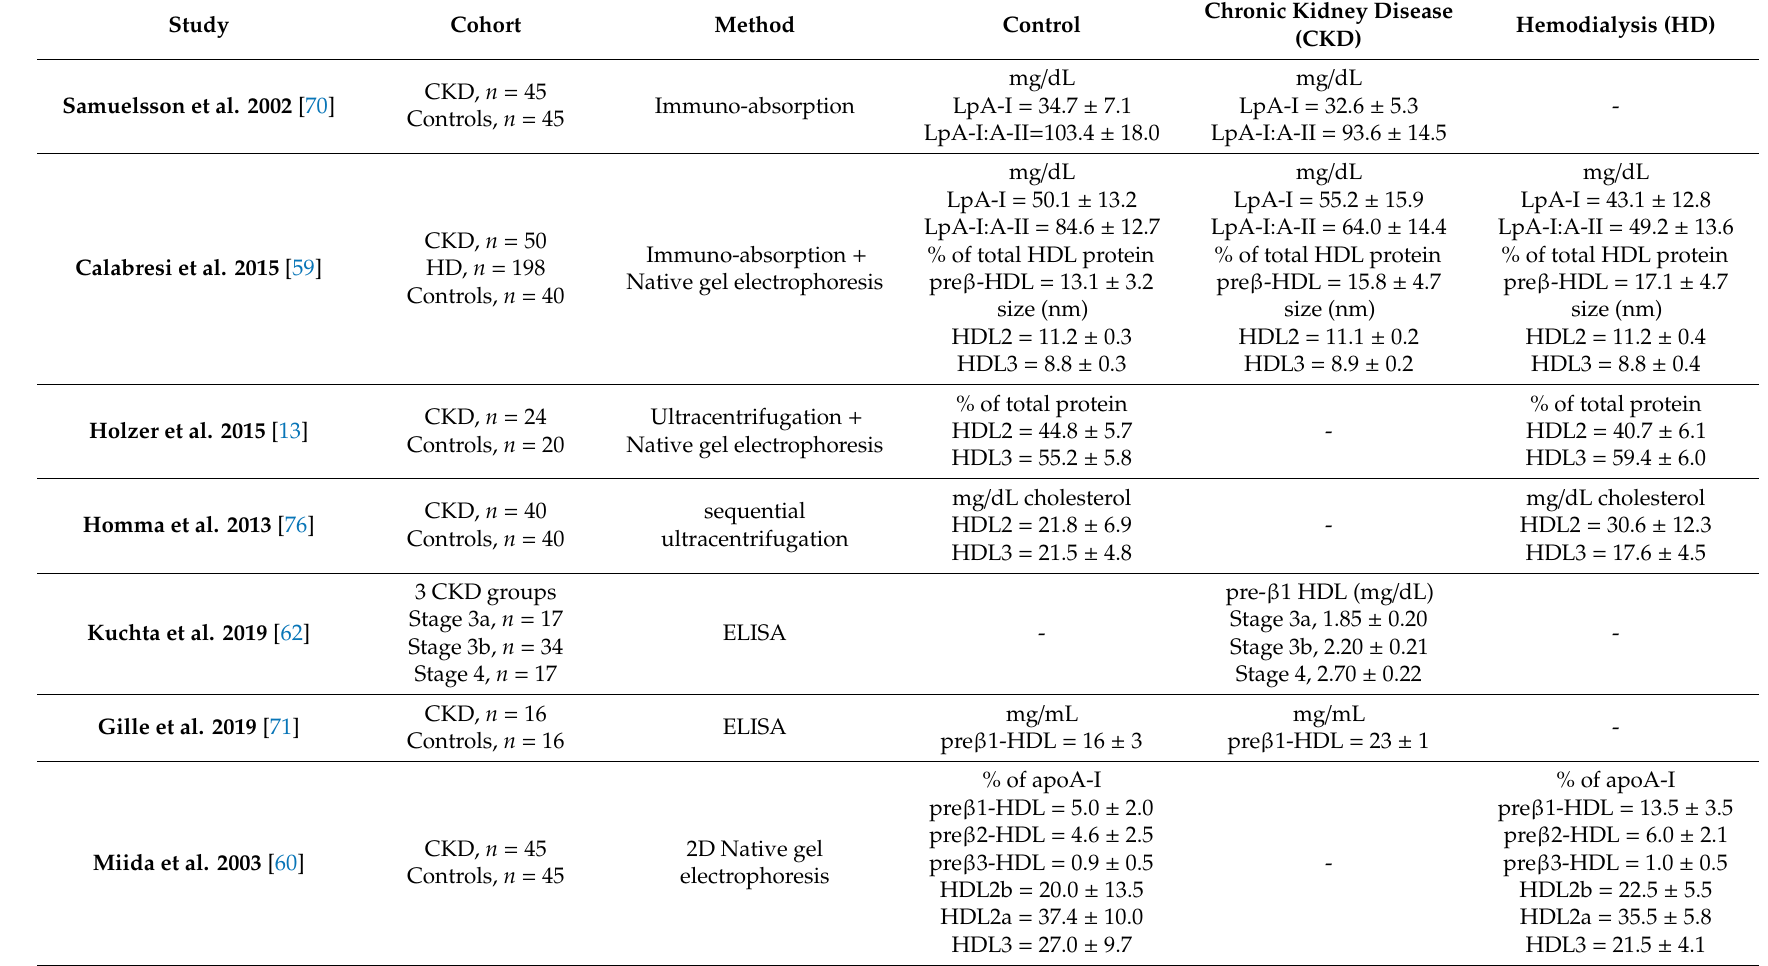
Table 2. Summary of studies investigating HDL subpopulations in chronic kidney